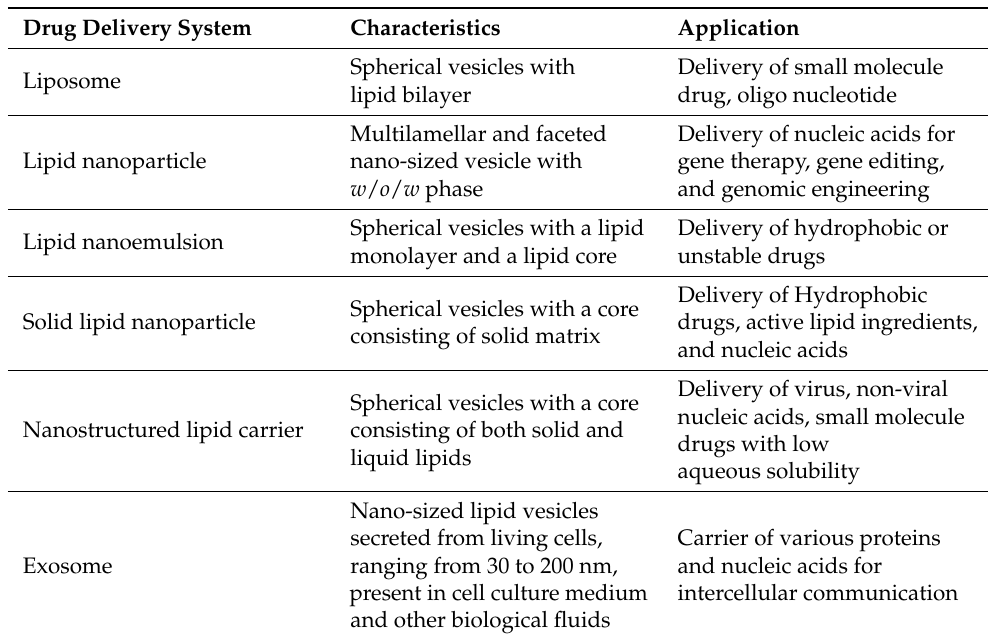
Table 2. Current Drug Delivery